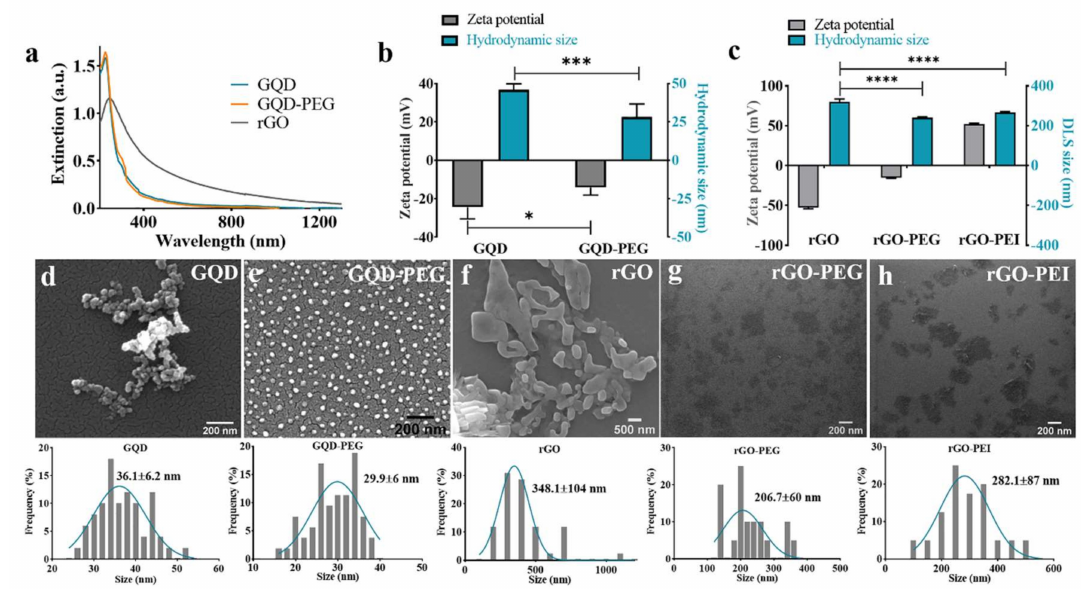
Figure 2. Characterization of physicochemical properties of GQD and rGO before and after functionalization with PEG or PEI. ( a ) The UV-NIR distinction spectra of GQD, GQD-PEG, and rGO. ( b ) Zeta potential and hydrodynamic size of GQD and GQD-PEG as measured by DLS in deionized water. ( c ) Zeta potential and hydrodynamic size of rGO, rGO-PEG, and rGO-PEI as measured by DLS in deionized water. SEM images and size distributions of ( d ) GQD, ( e ) GQD-PEG, ( f ) rGO, ( g ) rGO-PEG, and h) rGO-PEI. A gold layer was applied to the GQD, GQD-PEG and rGO samples. while the rGO-PEG and rGO-PEI were directly imaged on a silicon wafer. * p < 0.1, **** p < 0.0001, and ns = not